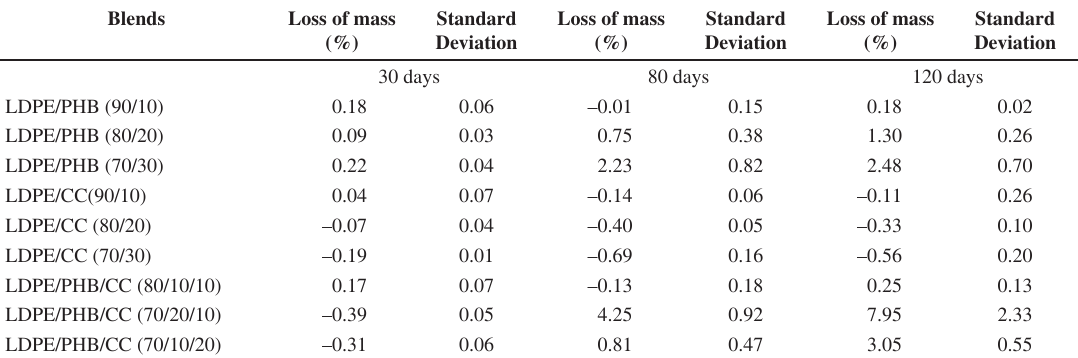
Table 4. Percentage of loss of mass of LDPE mixtures in different intervals of time. Blends